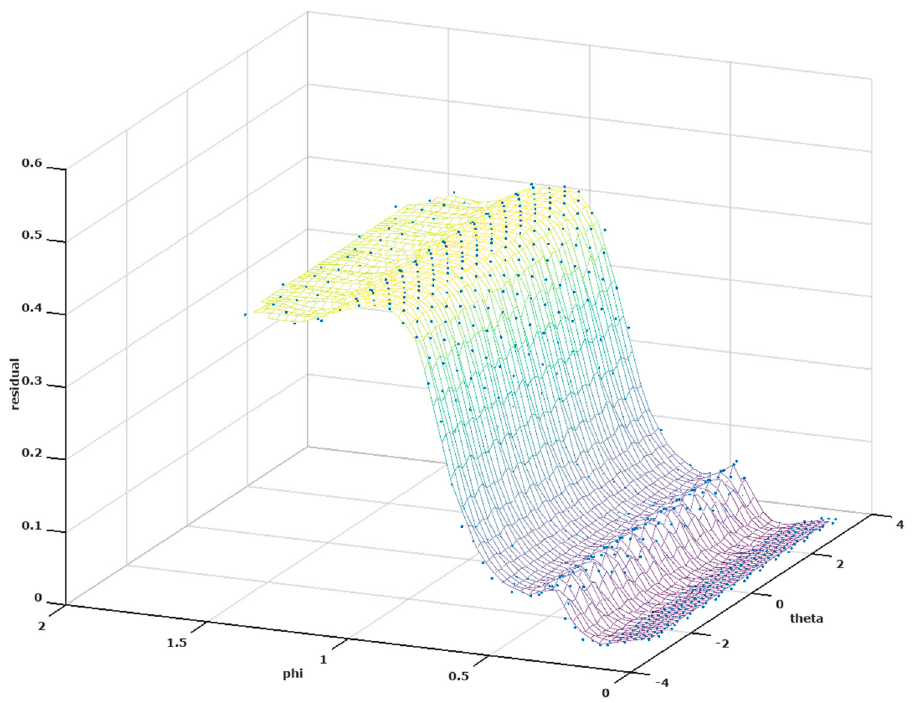
Figure 5. Residual at all candidate sources for an illustrative noise-free case. All good candidate sources (low residual) reside at the same elevation (phi), with a range of azimuths (theta) that covers the entire 2 π radians.